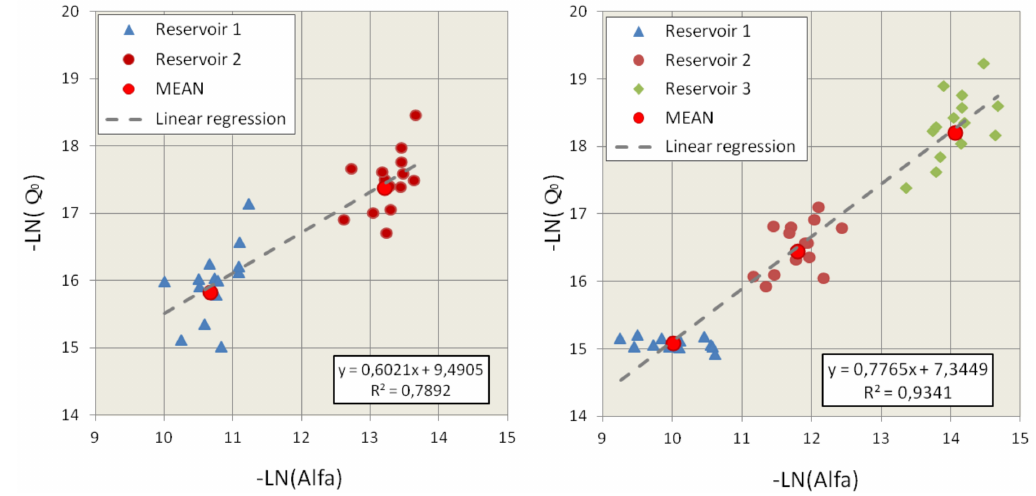
Figure 4. Calibration parameters, Q 0 and α , of the 14 recession curves for the 2R and 3R models.